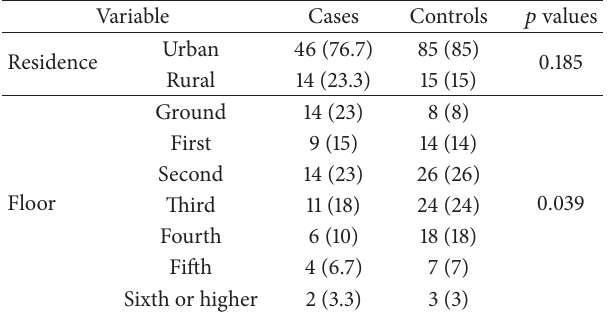
Table 5: Multivariable binary logistic regression model for risk